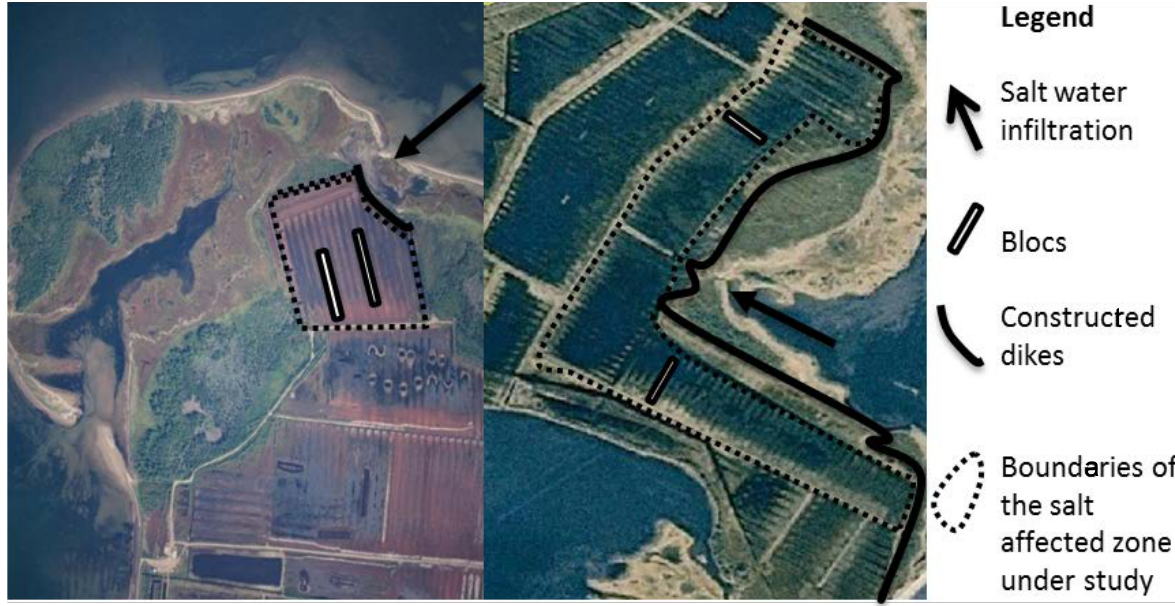
Figure A2. Aerial photographs of the study sites, Pokesudie bog (left) and Shippagan bog (right). Both are located on the Acadian Peninsula of New Brunswick,